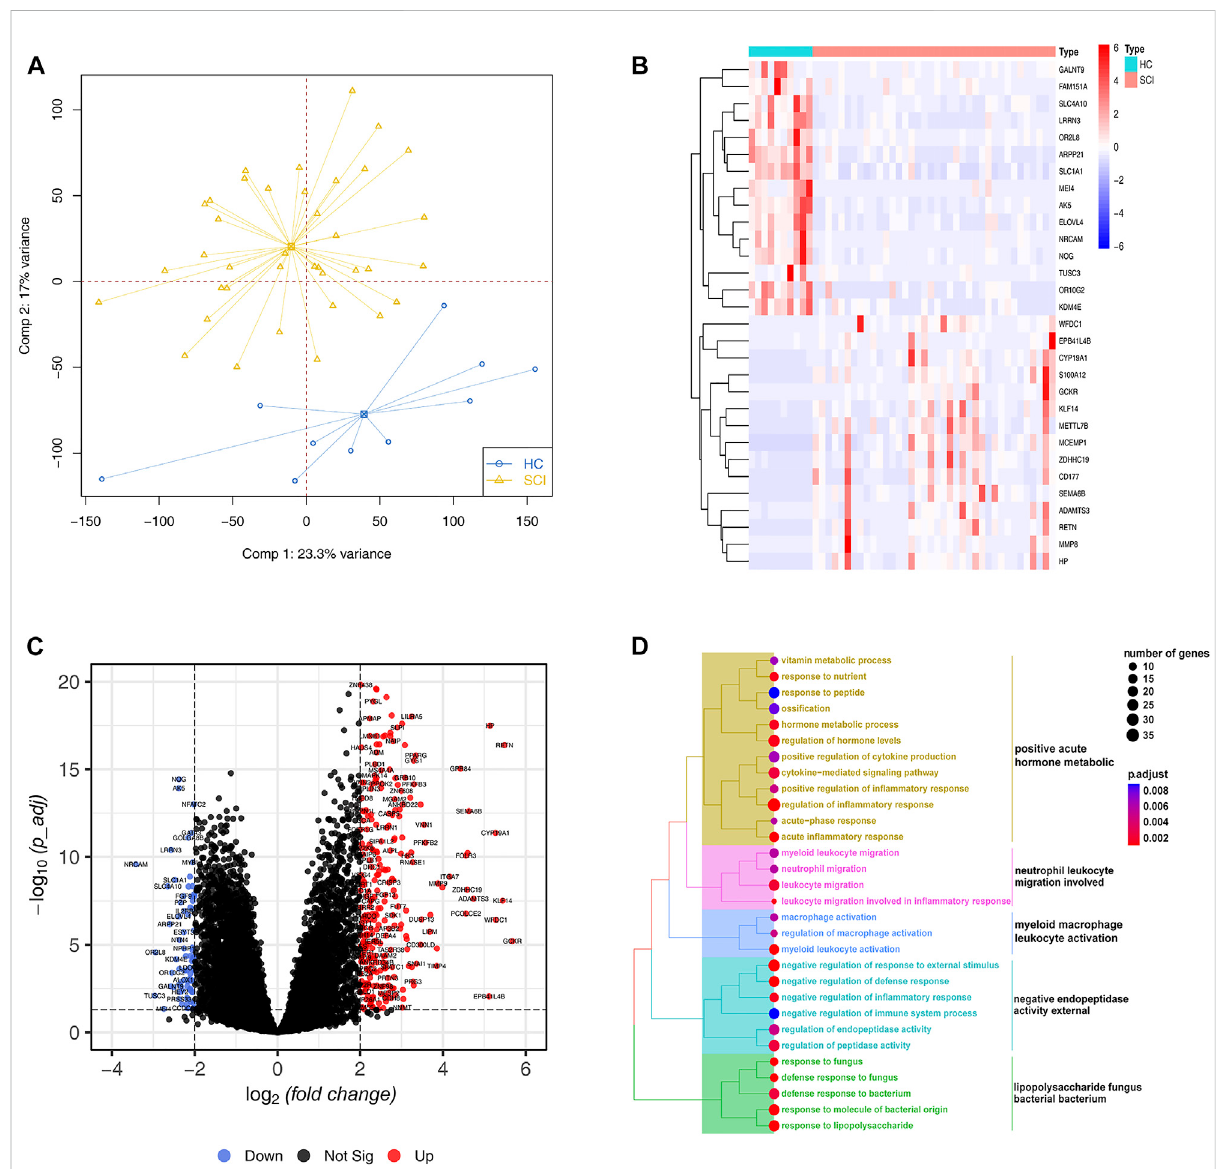
Differential expression and enrichment analysis. (A) Principal component analysis for the expression pro fi les to distinguish spinal cord injury (SCI)fromhealthycontrols(HC)inGSE151371cohort.TwosubgroupsareclearlydistinguishedbasedonthemRNAexpressionlevels.SCIsamplesare marked with yellow and healthy controls marked with blue (B) Heatmap plot oftop 30differentially expressedgenes (DEGs) from thecomparison of SCI with HC fi ltered by the fold change. High expression is indicated in red and low expression is indicated in blue. (C) The volcano plot shows the number and distribution of all genes. Each dot represents one gene with differential up-regulated in SCI (red), differential down-regulated (blue) or no signi fi cant difference (black). (D) The treeplot shows GO and KEGG enrichment summary of DEGs. GO terms and KEGG pathways categories are grouped according to functional